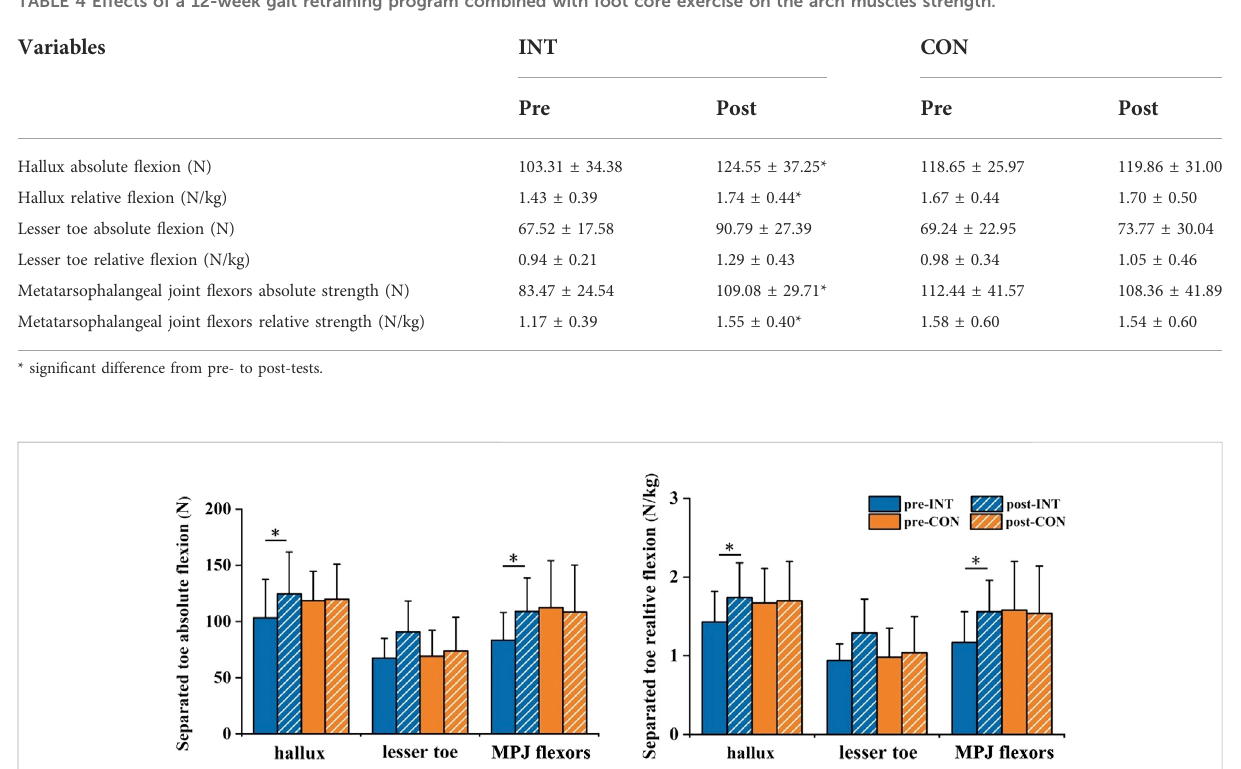
TABLE 4 Effects of a 12-week gait retraining program combined with foot core exercise on the arch muscles strength.